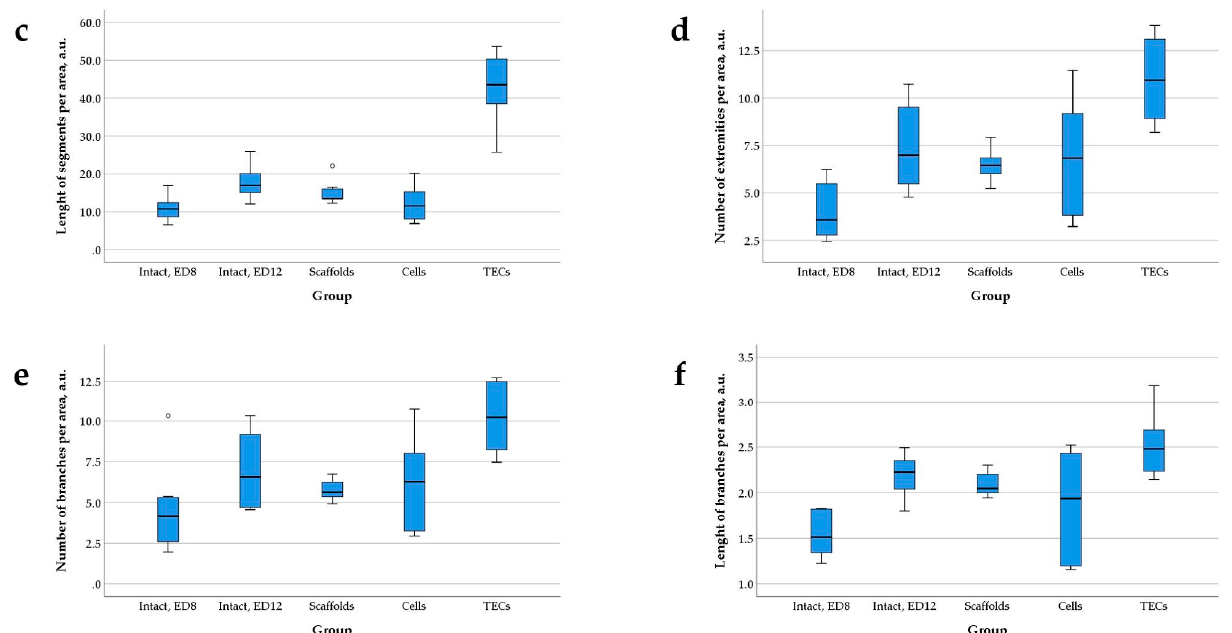
Figure A13. Quantitative analysis of angiogenesis. The parameters of the blood vessel tree are reflected as values per unit area. ( a ) Total blood vessels’ density, × 10 − 5 ; ( b ) number of Junctions, × 10 − 10 ; ( c ) length of segments, × 10 − 5 ; ( d ) number of extremities, × 10 − 10 ; ( e ) number of branches, × 10 − 10 ; ( f ) length of branches, × 10 − 5 . The results are presented as boxplots, where thick dark horizontal line shows mean values, blue boxes indicate CI 95% for the mean, and the whiskers indicate the minimal and maximal observed values.